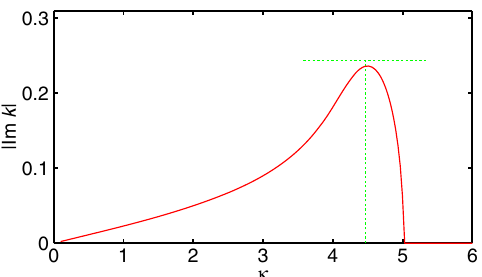
FIG. 1. The growth rate j Im k j as a function of κ . The dispersion curve is obtained by solving Eq. (20) with Ω ¼ f ¼ 1 . The green dashed lines indicate the analytical and f B R approximate solutions of the maximum growth rate max j Im k j [Eq. (21)] at κ ≈ Ω syn ; 0